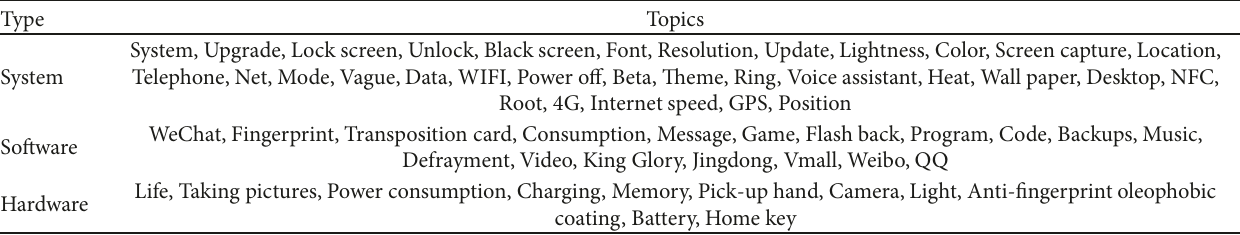
Table 1: Classification of